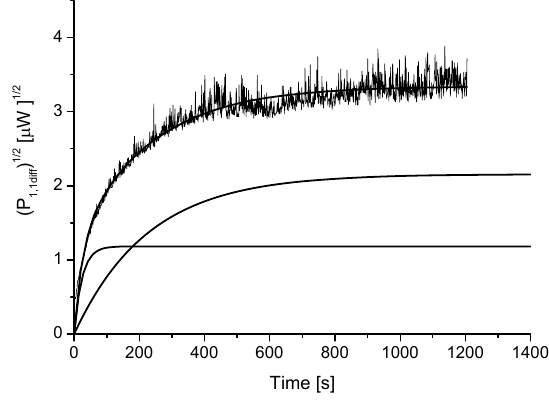
Fig. 6 Curve fitting for obtaining time constants of diffraction grating build-up in a photochromic polymer. The contributing exponential growth functions have parameters: A = 1.18, τ r = 24 s and B = 2.16, τ r = 226 1 2